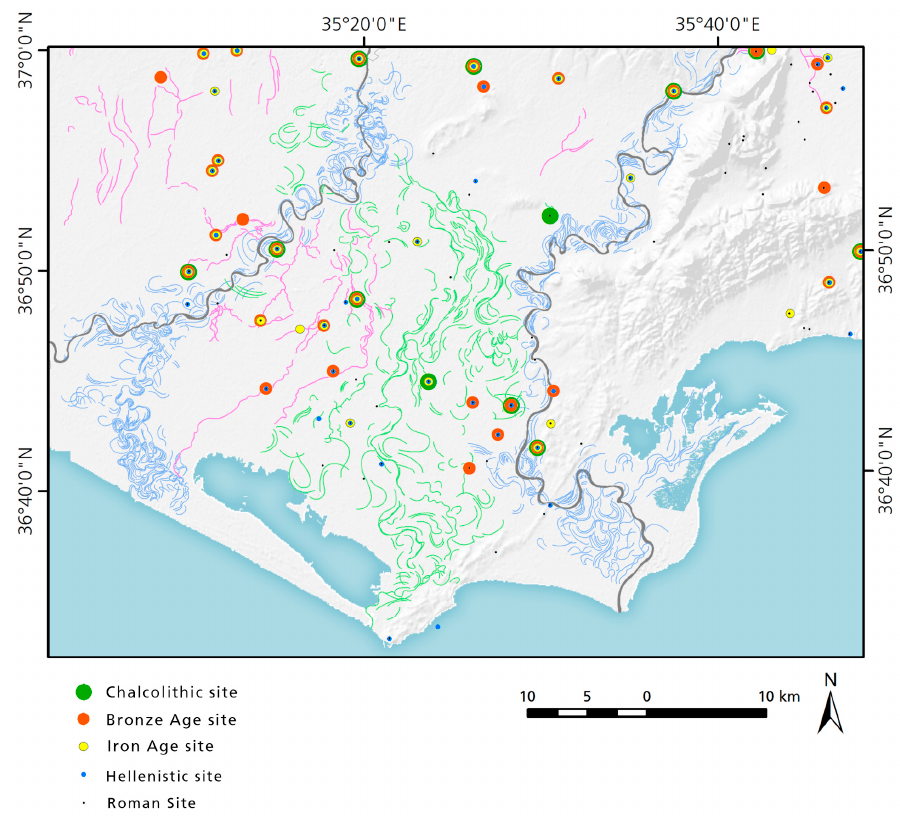
Figure 12. Sites dating from the Chalcolithic to the Roman Period in the Çukurova as well as palaeochannels and relict canals © Susanne Rutishauser.